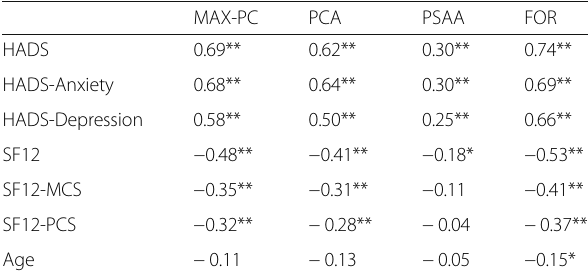
Table 5 Criterion and construct validity of the French version of the MAX-PC (Pearson correlation coefficients, N = 185) MAX-PC PCA PSAA